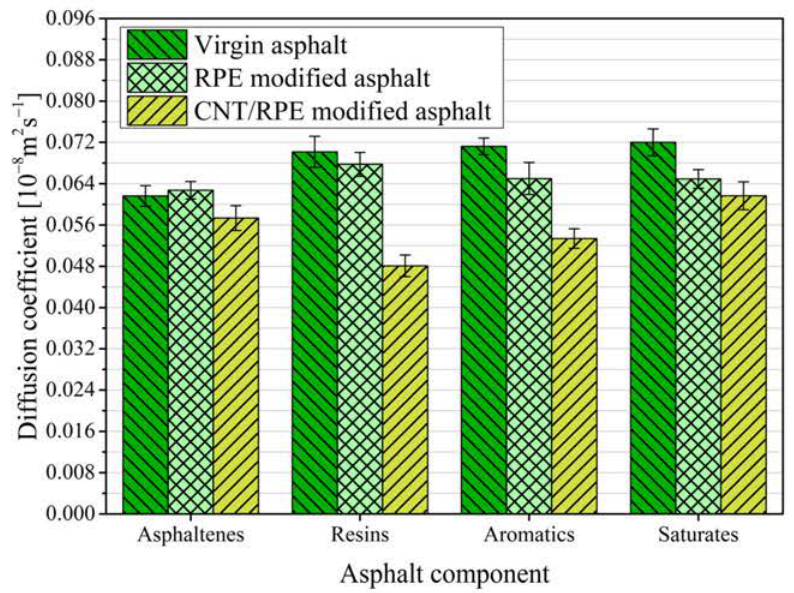
Figure 12. Results of diffusion coefficients for three